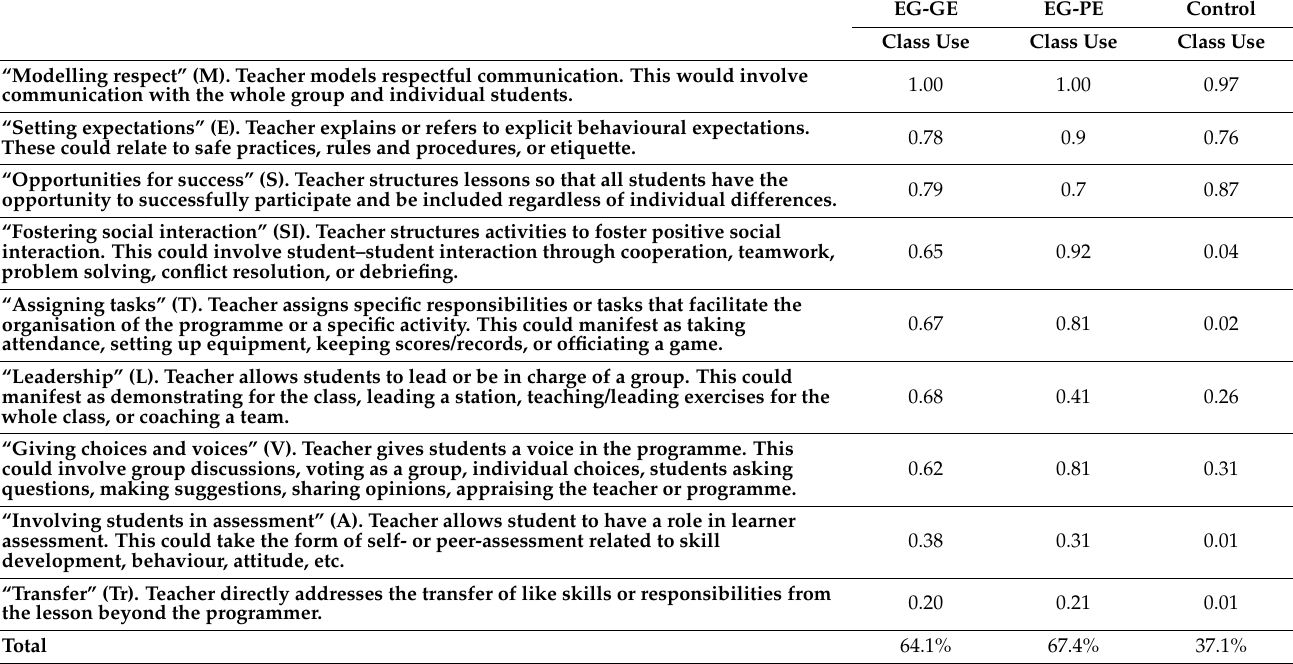
Table 2. Fidelity Implementation Instrument.